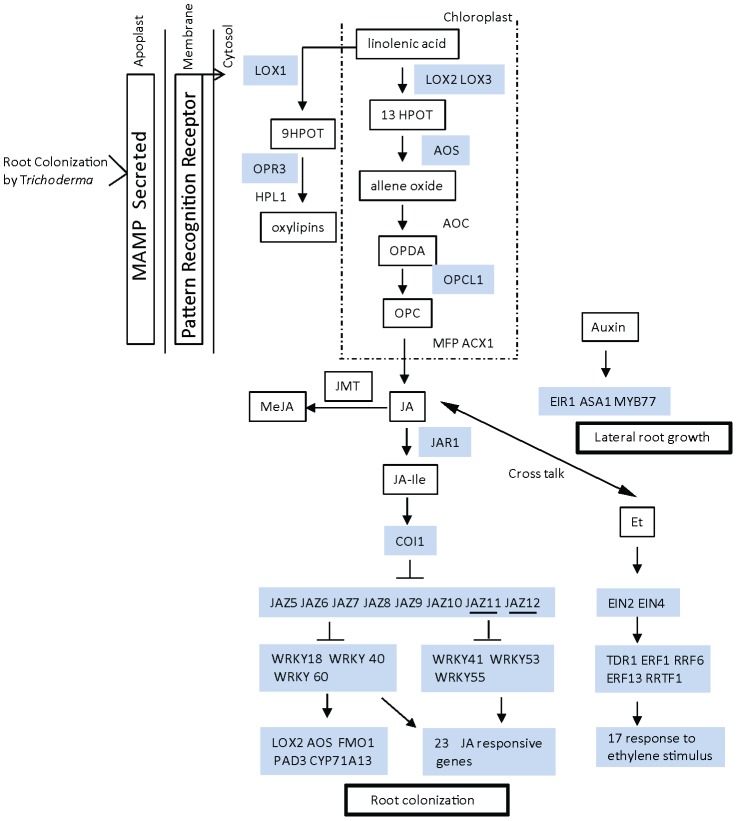
Overview of modulation of expression of phyto-hormone biosynthesis and responsive genes in Arabidopsis roots during Trichoderma colonization.In the early steps of the interaction, Trichoderma secreted MAMPs that triggered activation of signal transduction which modulated the expression of several genes. Among them, genes that have been previously shown to have a role in biosynthesis and response to JA, ethylene (Et; significant enrichment, FDR: P<0.01) and auxin (non-significant enrichment). Based on previously published data, we propose two main biological roles for the activation of those phyto-hormone related pathways in the plant-Trichoderma interaction: (i) colonization regulated by JA and ethylene, and (ii) lateral root formation regulated by JA and ethylene. Intermediate metabolites in the biosynthesis pathways are indicated by bold frame. Genes mediating the biosynthesis process are indicated without frame or marked in blue in case they show a significant (P<0.05) change in expression level upon Trichoderma colonization. Down-regulated genes are underlined. The model is based on the following published studies [28], [30], [39]–[41], [50], [76]–[78] and the oxylipins pathway (based on KEGG pathways). Gene names are in conformity with TAIR annotation.